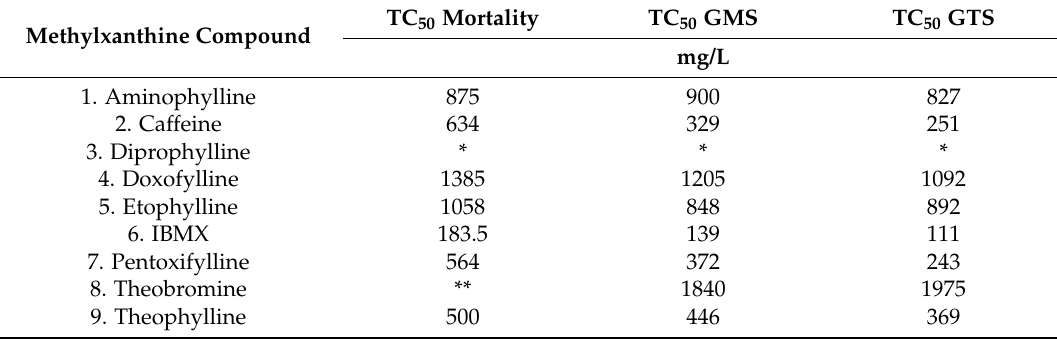
Table 2. TC 50 Mortality, TC 50 GMS and TC 50 GTS of the nine methylxanthine compounds tested on zebrafish embryos in the FET test.